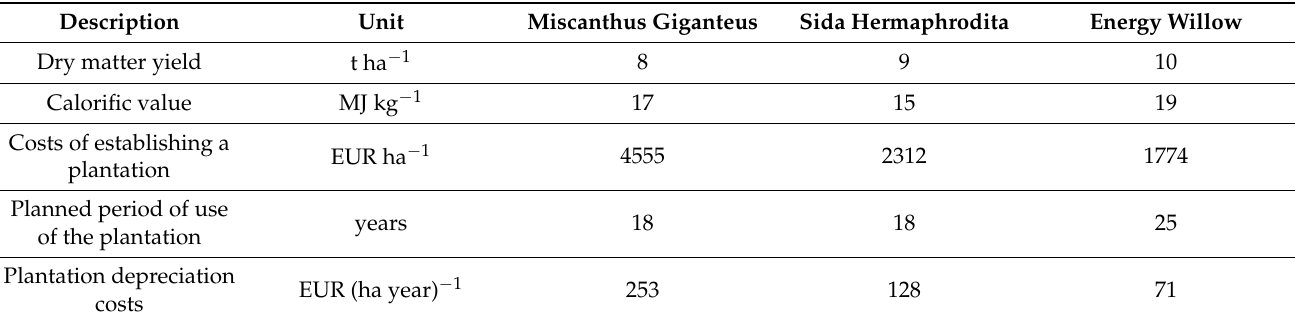
Table 2. Calculation assumptions for selected energy